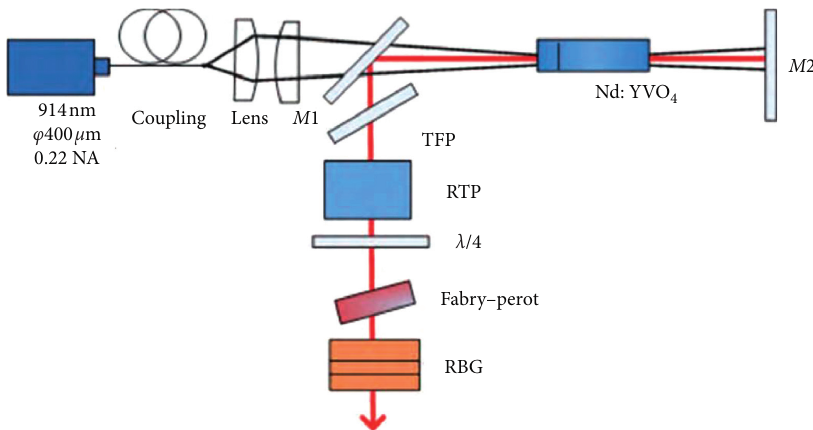
Figure 21: Schematic of a SLM laser based on etalon and RBG